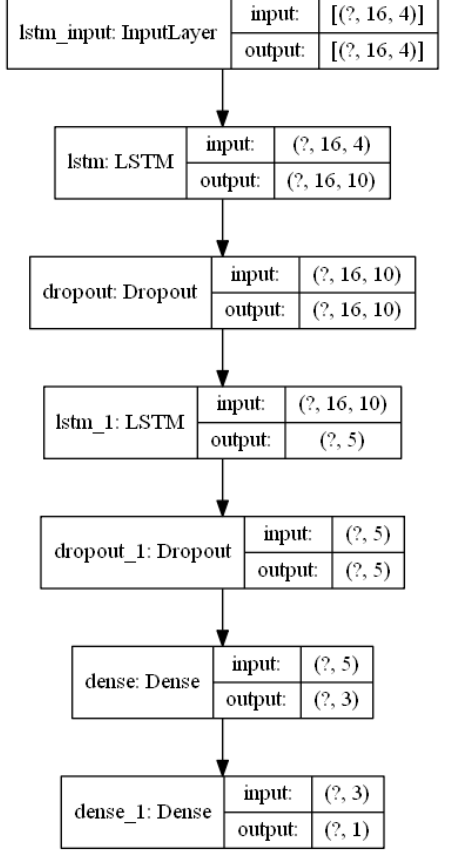
Figure 4. RNN model parameters.